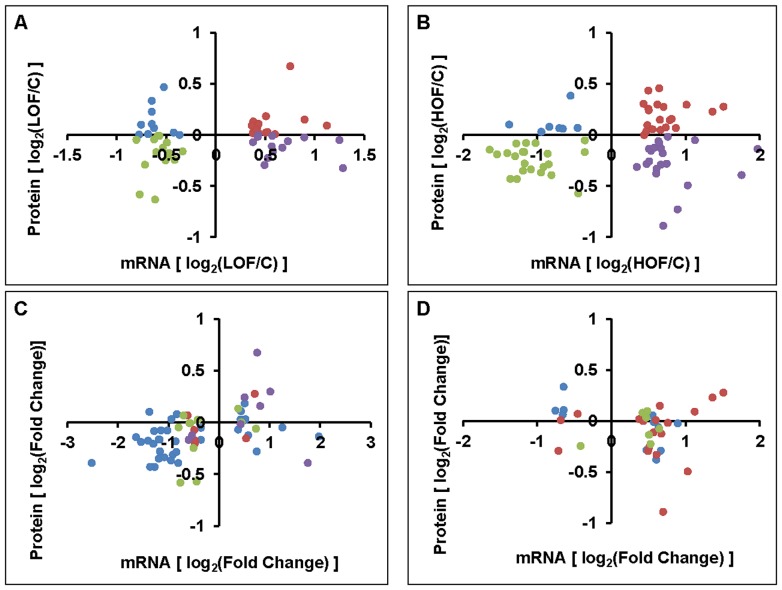
Correlation analysis towards the differential proteins and corresponding mRNAs in LOF and HOF.(A and B) Scatter plot correlation analysis of the differentially expressed proteins and corresponding mRNAs in LOF (A) and HOF (B). The log2 values of the normalized fold changes for the differential proteins are plotted against those of the corresponding mRNAs in LOF or HOF. The spots with different colors represent the four modes: red, up-regulated protein and mRNA; green, down-regulated protein and mRNA; blue, down-regulated protein but up-regulated mRNA; and purple, up-regulated protein but down-regulated mRNA. (C and D) Scatter plot correlation analysis of the differentially expressed proteins and corresponding mRNAs in certain functional groups (C, proteins uniquely localized to the mitochondria; D, mitochondria-associated proteins). Different colors represent different functional groups. 4C: blue, respiratory chain proteins; red, mitochondrial translation; green, carbohydrate/lipid metabolism; and purple, chaperones. 4D: blue, calcium regulation; red, membrane-associated; and green, amino acid synthesis/metabolism.